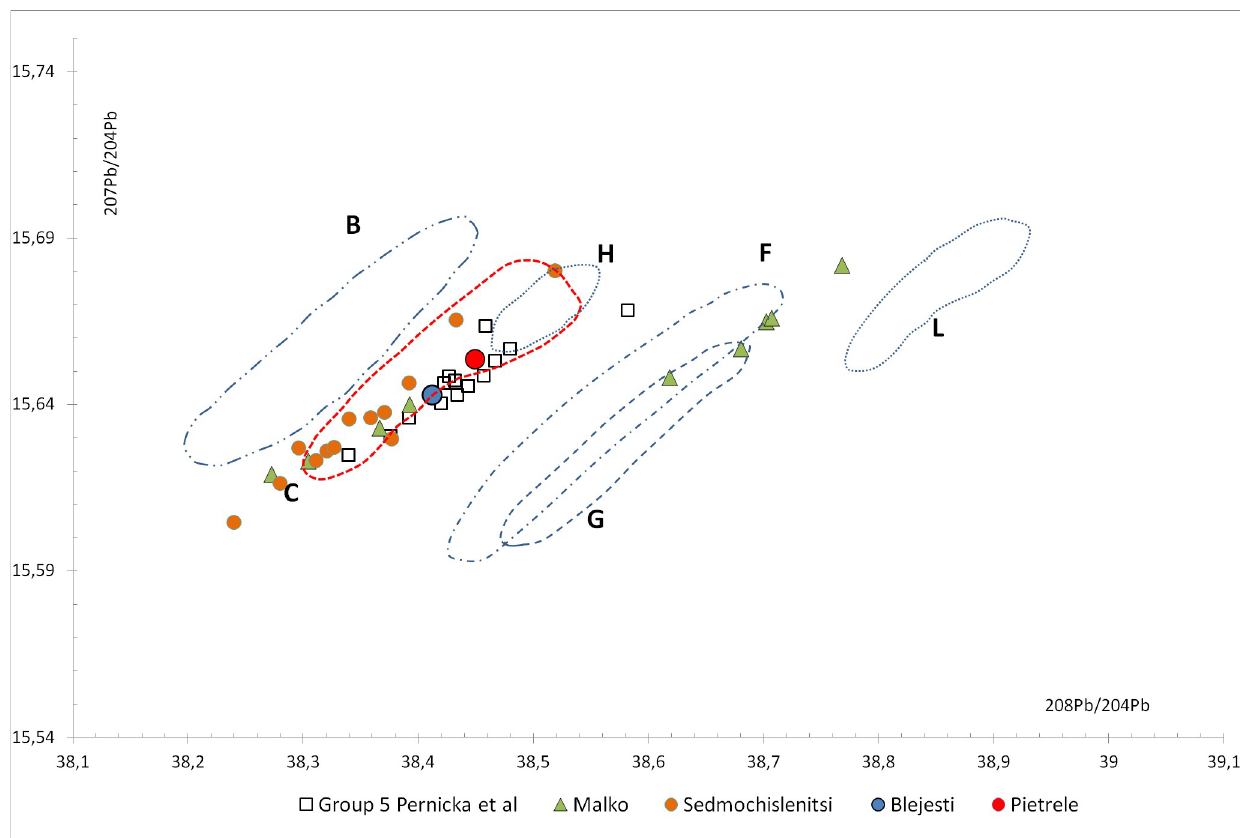
Fig 25. Lead isotope ratios of Bleje ş ti 1–2 and Pietrele P06F3741096 samples compared with isotopic fields defined by [47], Bulgarian metal group 5 by [43] and ores from Sedmochislenitsi and Malko Turnovo deposits [44] (I. Montero).